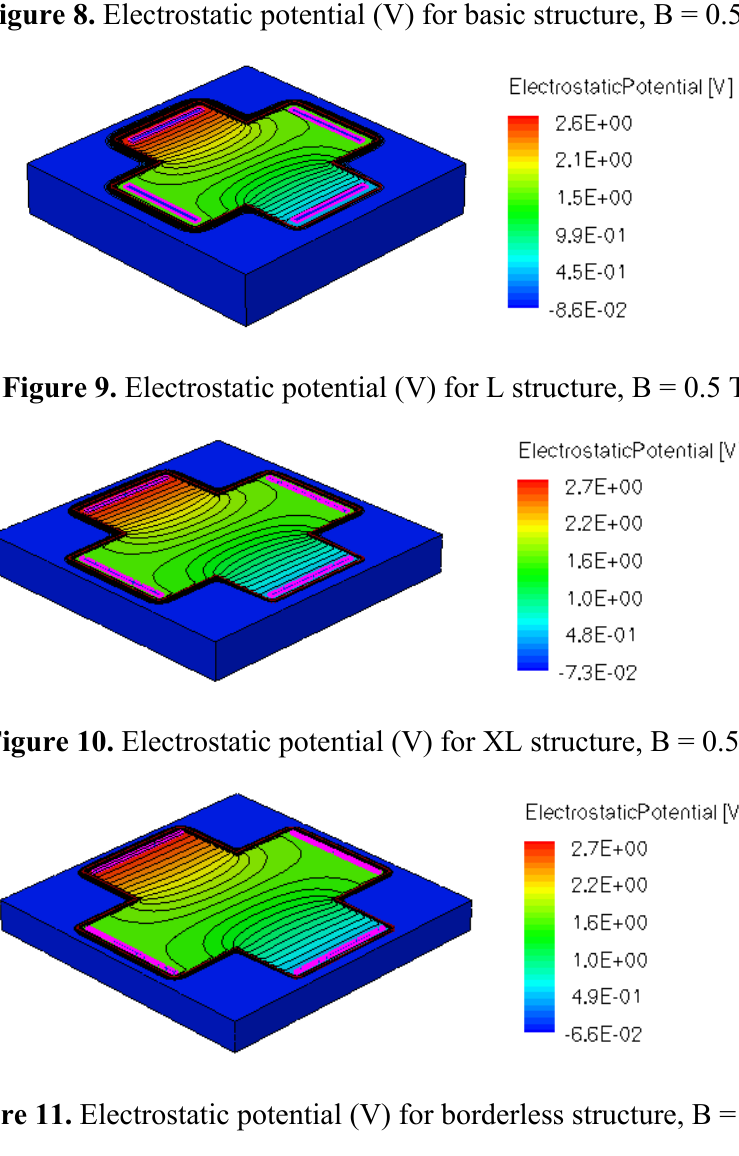
Figure 8. Electrostatic potential (V) for basic structure, B = 0.5 T.